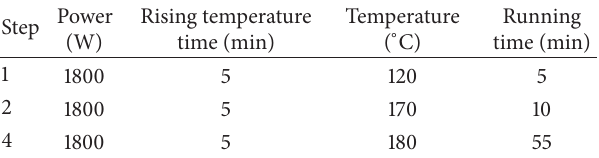
Table 1: Microwave digestion parameters.